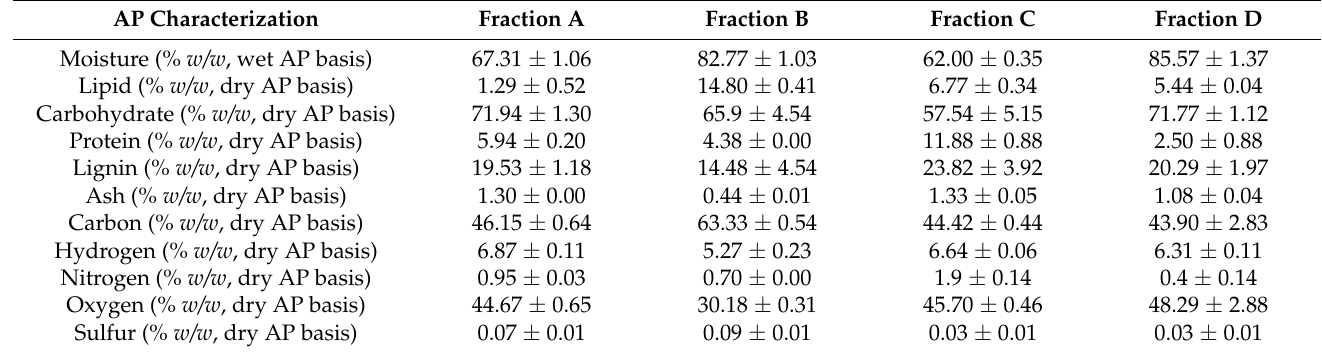
Table 1. Physicochemical characterization of the different tested fractions of waste apple pomace used in this